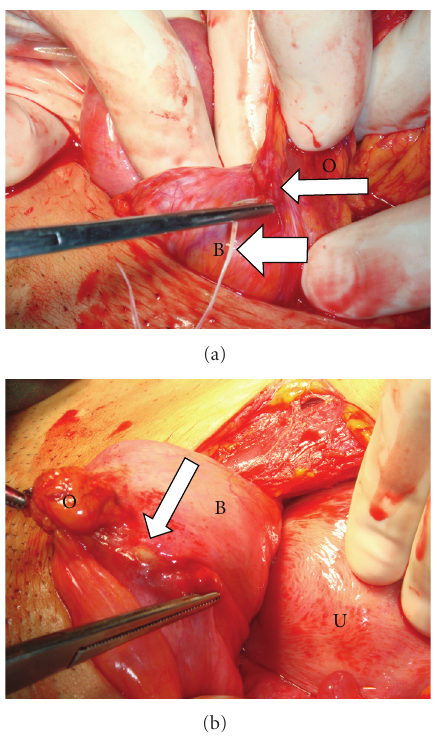
Figure 2: (a) Anterior view of the bladder. The thick arrow shows the string and the thin arrow shows the horizontal limb of the intrauterine device. Adhesions between the bladder (B) and omentum (O) are observed. (b) Posterior view of the bladder. The arrow shows the vertical limb penetrating the posterior wall of the bladder (B). Uterus (U) and omentum (O) are also